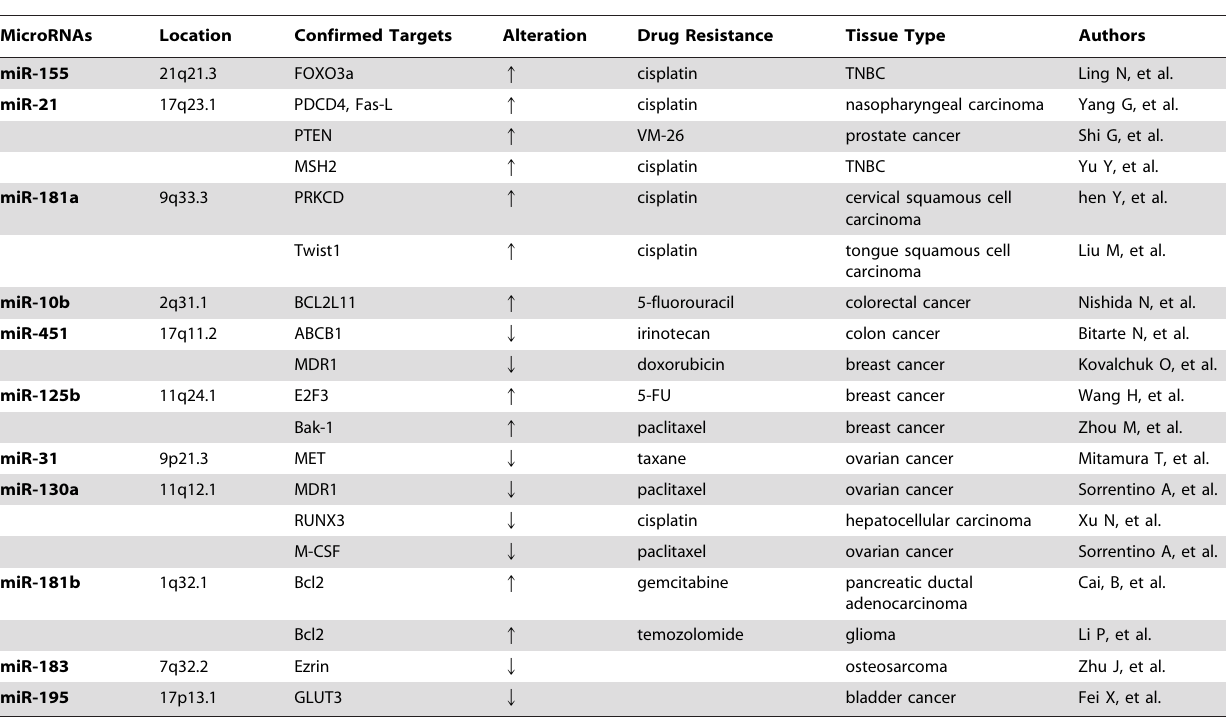
Table 1. Chemoresistance-related miRNAs of the 11 selected miRNAs.